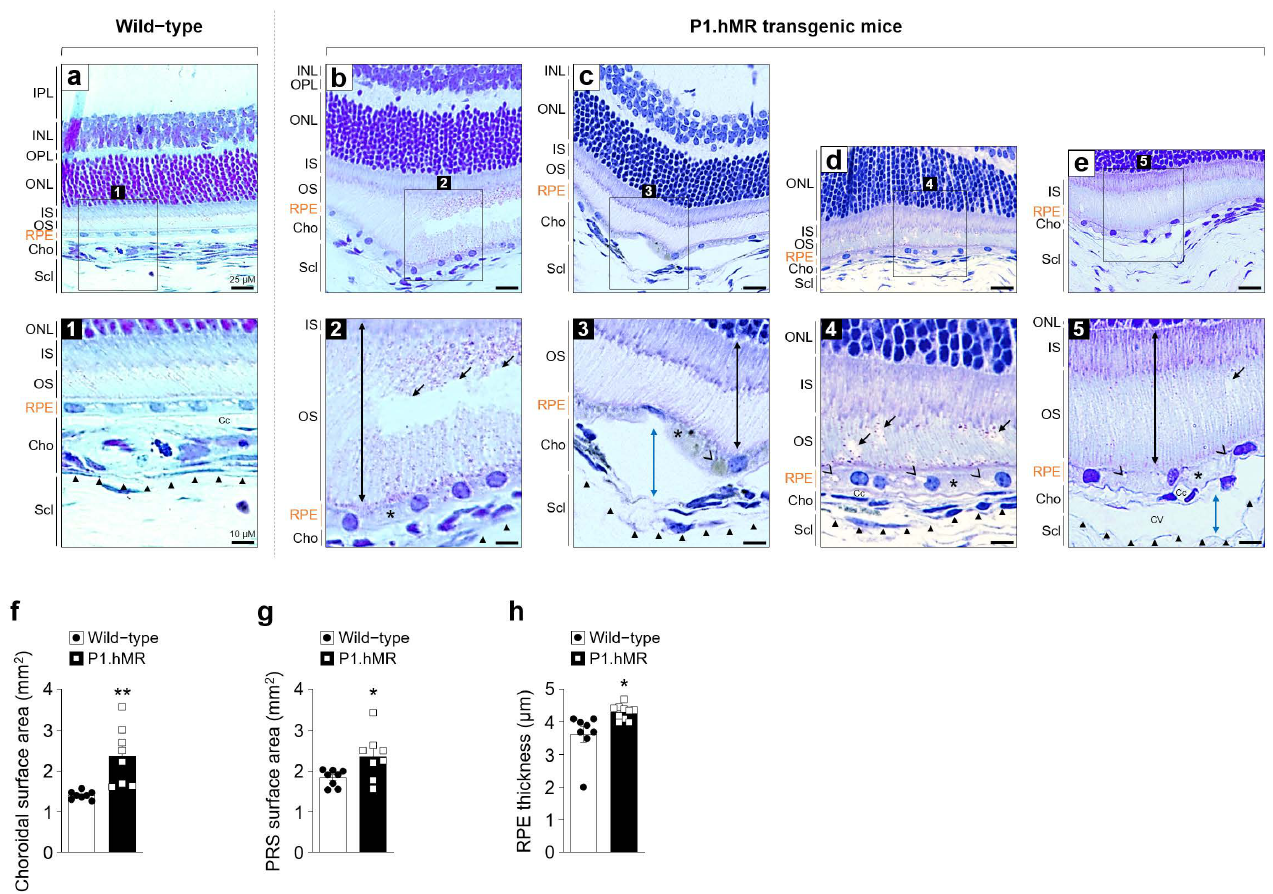
Figure 11. Histologic phenotype of P1.hMR mice. ( a – e ) Representative histologic sections of the retina from wild-type and P1.hMR transgenic mice at nine months of age. Sections are stained with toluidine blue. Black triangles delineate the limit between the choroid and the sclera. Inset (1) showed normal mouse outer retina. Insets ( 2 – 5 ) show histological regions where choroidal vessels are dilated (blue double arrows), RPE cells are swollen (black asterisks) with accumulation of vacuoles (black arrowheads), and the outer retina is disorganized by fluid accumulation (black arrows) and elongation of the inner and outer segments of photoreceptors (black double arrows). Scale bar: 25 µ m ( a – e ) and 10 µ m ( 1 – 5 ). ( f – h ) Choroidal surface area ( f ), photoreceptor segments surface area ( g ) and RPE thickness ( h ) were quantified on retina sections from wild-type and P1.hMR transgenic mice ( n = 8 eyes). Values are means ± SEM. Unpaired t -test with Welch’s correction. * p < 0.05, ** p < 0.01. P1, proximal functional alternative promoter 1 upstream of the first two untranslated exons 1 α and 1 β of the hMR gene; IPL, inner plexiform layer; INL, inner nuclear layer; OPL, outer plexiform layer, ONL, outer nuclear layer; IS, inner segment; OS, outer segment; RPE, retinal pigment epithelium; Cho, choroid; Scl, sclera; Cc, choriocapillaris; CV, choroidal vessel; PRS, photoreceptor